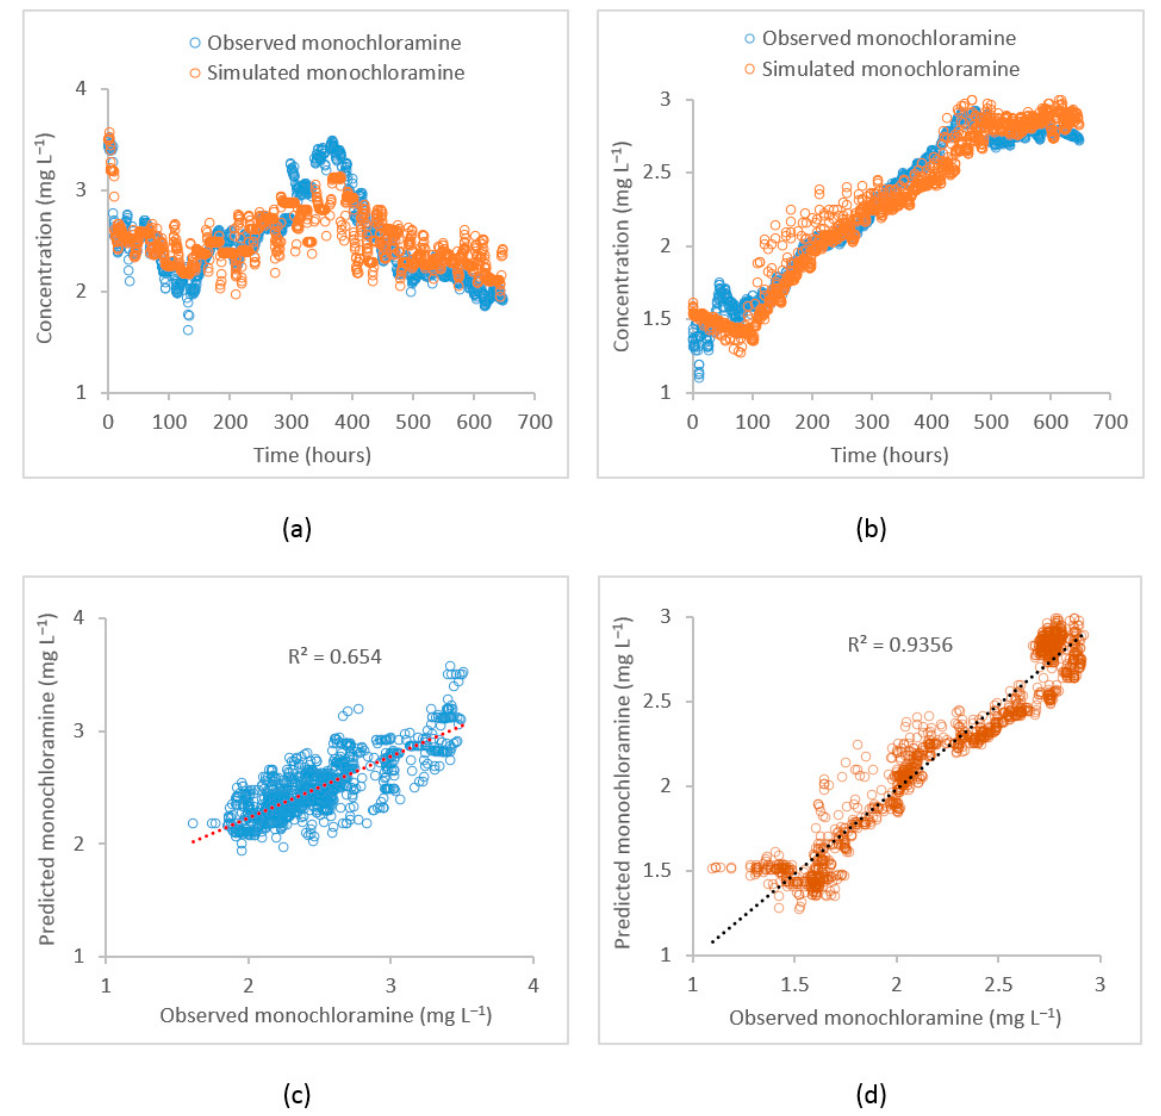
Figure 5. Plot of the observed vs. the simulated monochloramine concentrations by the EPANET model during model calibration. ( a ) Time ‒ series at the PS2 inlet, ( b ) time ‒ series at Meningie, ( c ) correlation plot at the PS2 inlet, and ( d ) correlation plot at Meningie.